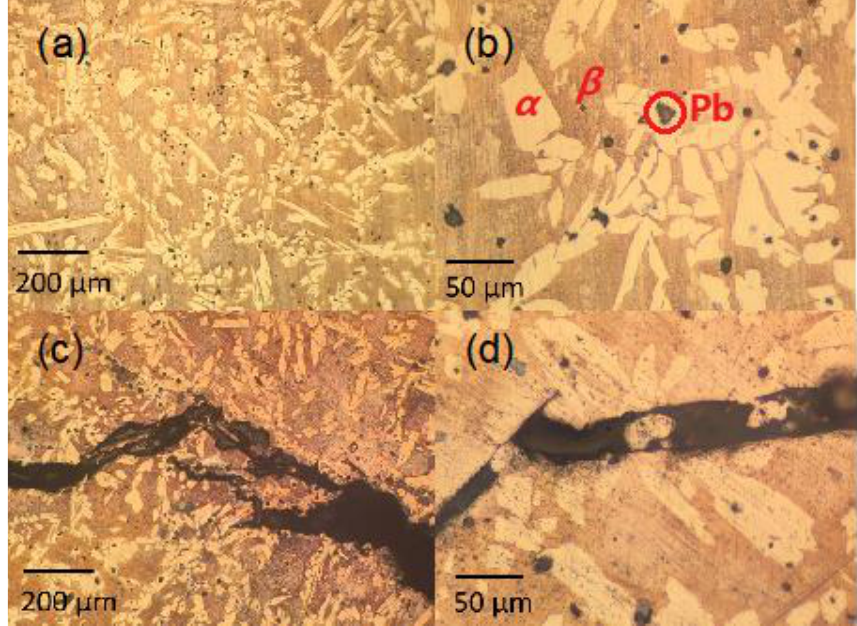
Figure 5. The metallographic figures of failed clamp on the ( a , b ) uncracking zone and the ( c , d ) cracking zone.